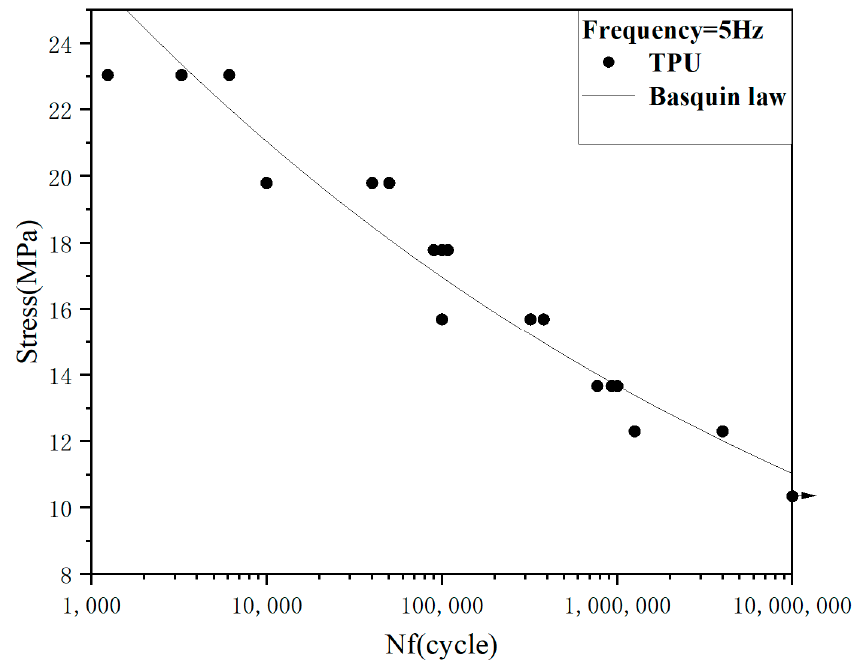
Figure 3. S-N curve of TPU.